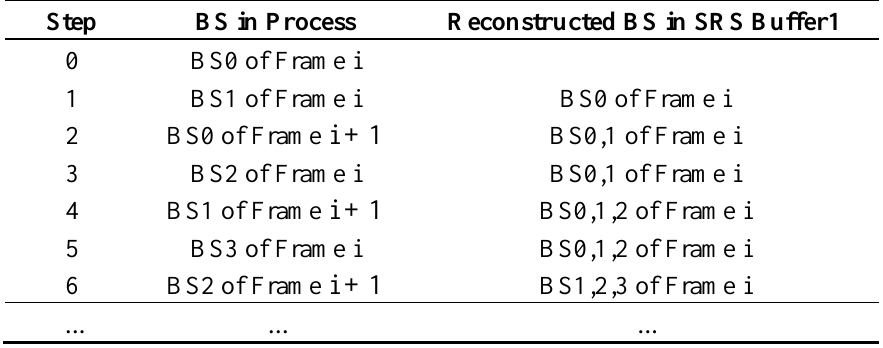
Figure 10. Inter-D Architecture for VC-SRME. Two SRS buffers are on-chip.